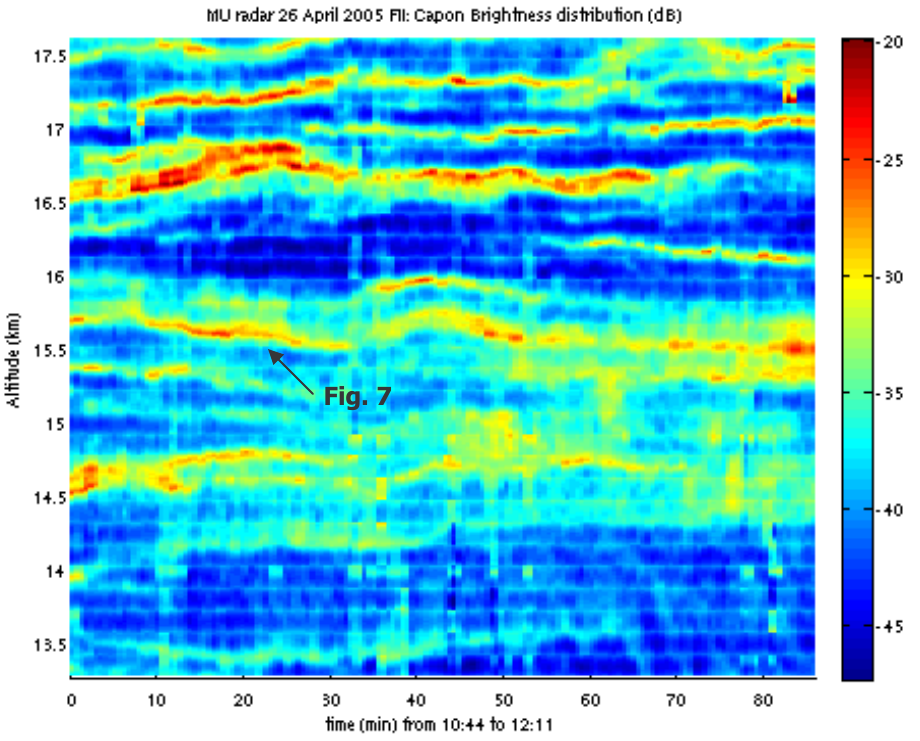
Fig. 3. Same as Fig. 1 for 13.05 to